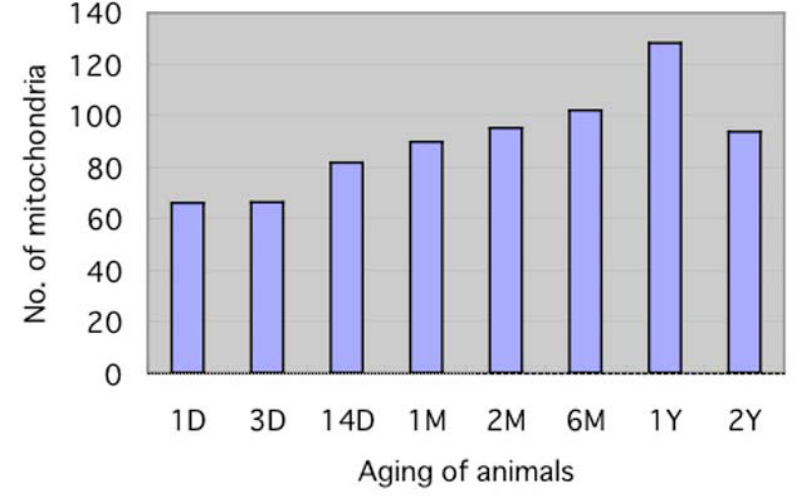
FIGURE 4 . Histogram demonstrating aging change of the total number of mitochondria per cell profile area in binucleate hepatocytes labeled with 3 H-leucine at respective aging groups from postnatal day 1 to postnatal month 24.